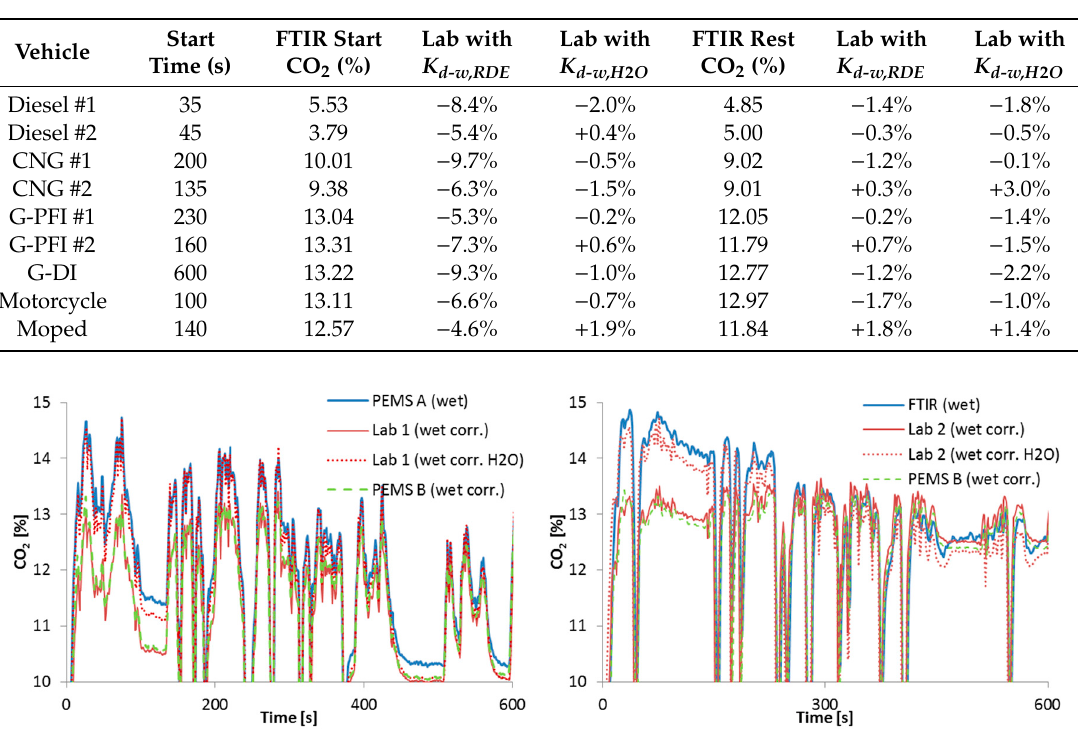
Figure 3. Comparison of different analyzers during cold start for some vehicles using the K d-w,RDE (wet corr.) or the K d-w,H 2 O (wet corr. H 2 O) equations for the same cycles as in Figure 2. Table4. Mean CO 2 concentration measurements (%) measured with the FTIR for the starting condensation period of the cycle and the rest of the cycle. The laboratory to the FTIR di ff erences are given using the two conversion factors (real driving emissions (RDE) or H 2 O). Vehicles and acronyms as in Table 2.